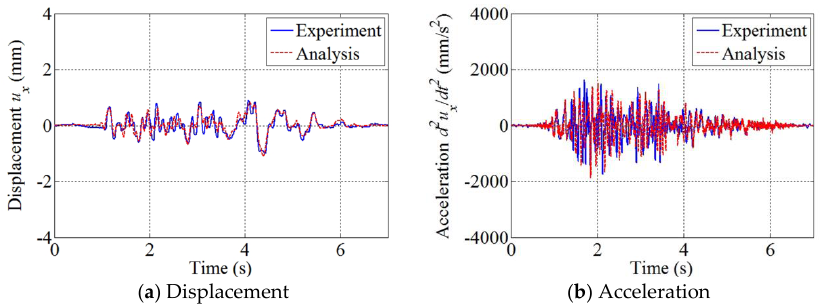
Figure 20. Second-floor response in the x direction due to the low-intensity ground motion; responses sampled at point A.